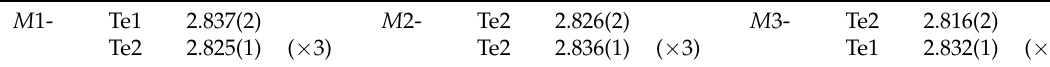
Table 6. Selected bond distances (Å) for